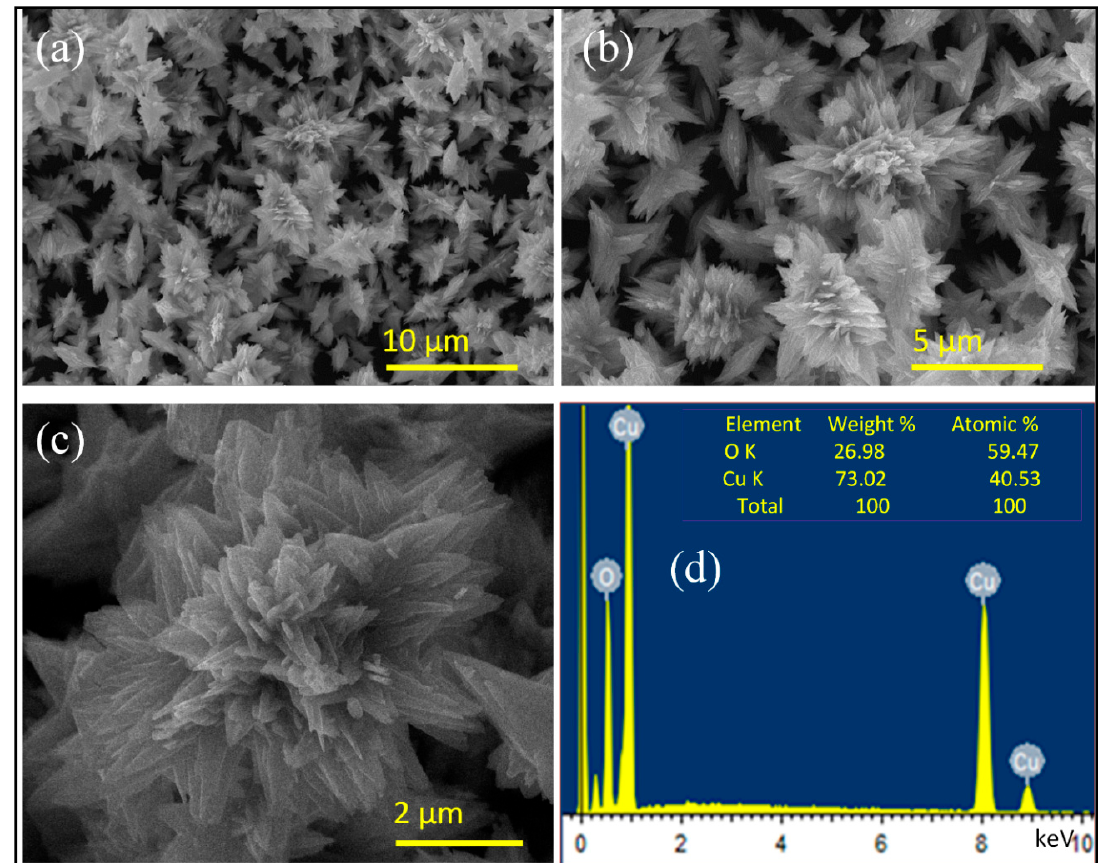
Figure 1. FE-SEM images and EDX analysis of CuO nanoflowers synthesized by controlled hydrothermal approach. ( a , b ) Low magnification; ( c ) high magnification; ( d ) EDX spectrum with elemental composition.